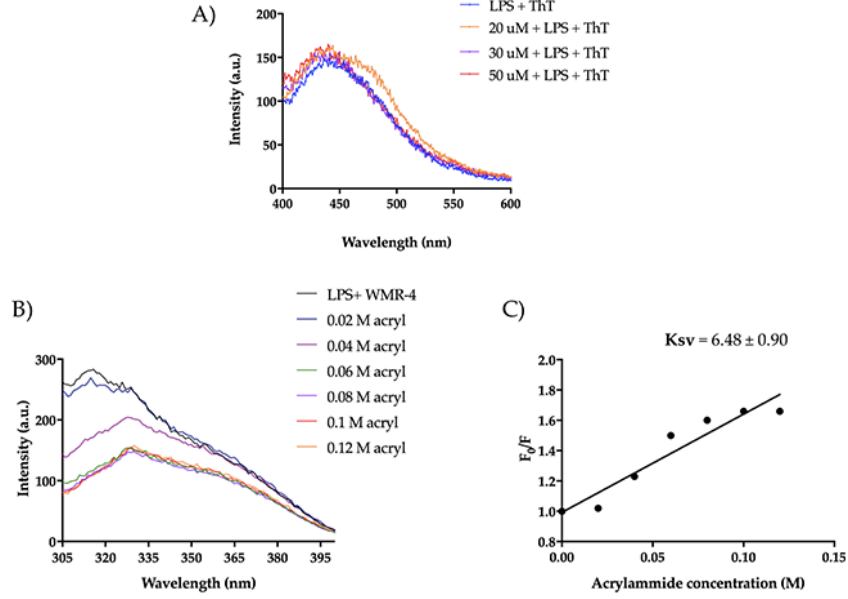
Figure 10. ( A ) ThT emission spectra after the incubation of WMR-4 (20, 30, and 50 μ M) with LPS. ( B ) Tryptophan fluorescence spectra for the peptide WMR-4 in LPS during the quenching with acrylamide at different concentrations. ( C ) Stern–Volmer (Ksv) quenching constant of WMR-4 in the presence of LPS.